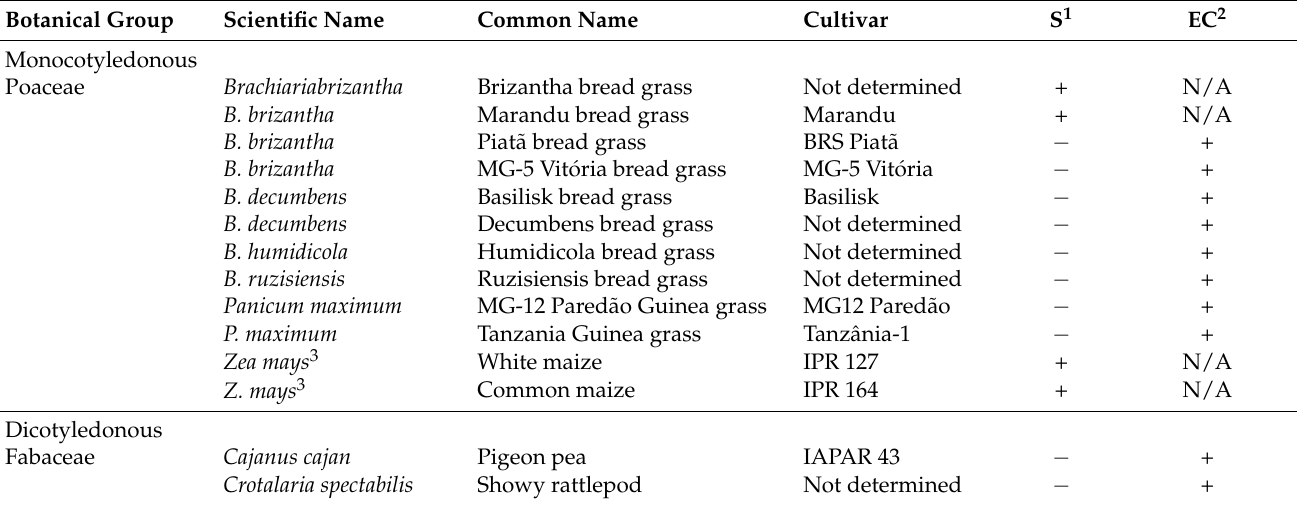
Table 2. Pathogenicity and epiphytic colonization of Xanthomonas vasicola pv. vasculorum ( Xvv ), the causal agent of bacterial leaf streak (BLS) of maize, in forage and